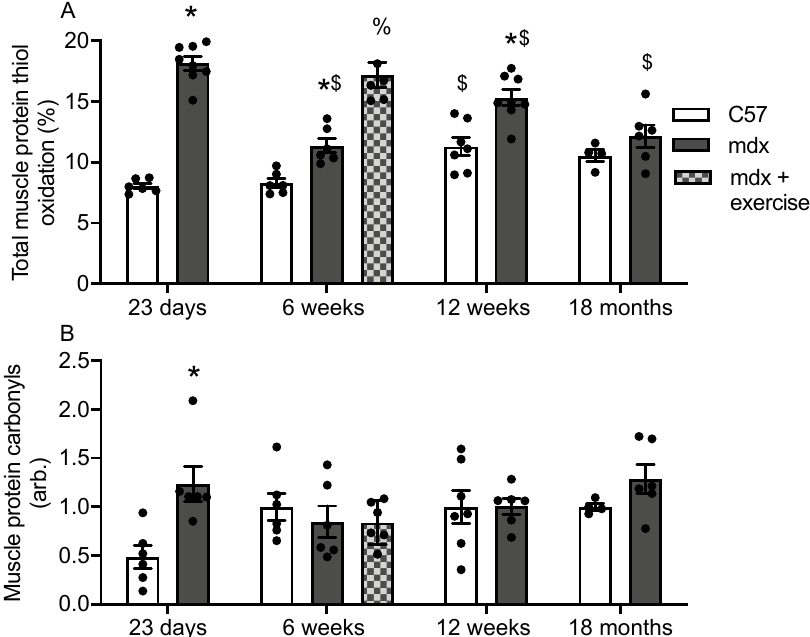
Figure 2. Protein thiol oxidation ( A ) and protein carbonylation ( B ) in C57 and mdx muscle at various time points. * = significantly ( p < 0.05) different to age matched control. % = significant ( p < 0.05) different to unexercised 6 week old mdx. $ = significantly ( p < 0.05) different to previous age group of same strain. Bars represent mean ± SEM and n = 5–8 per group.